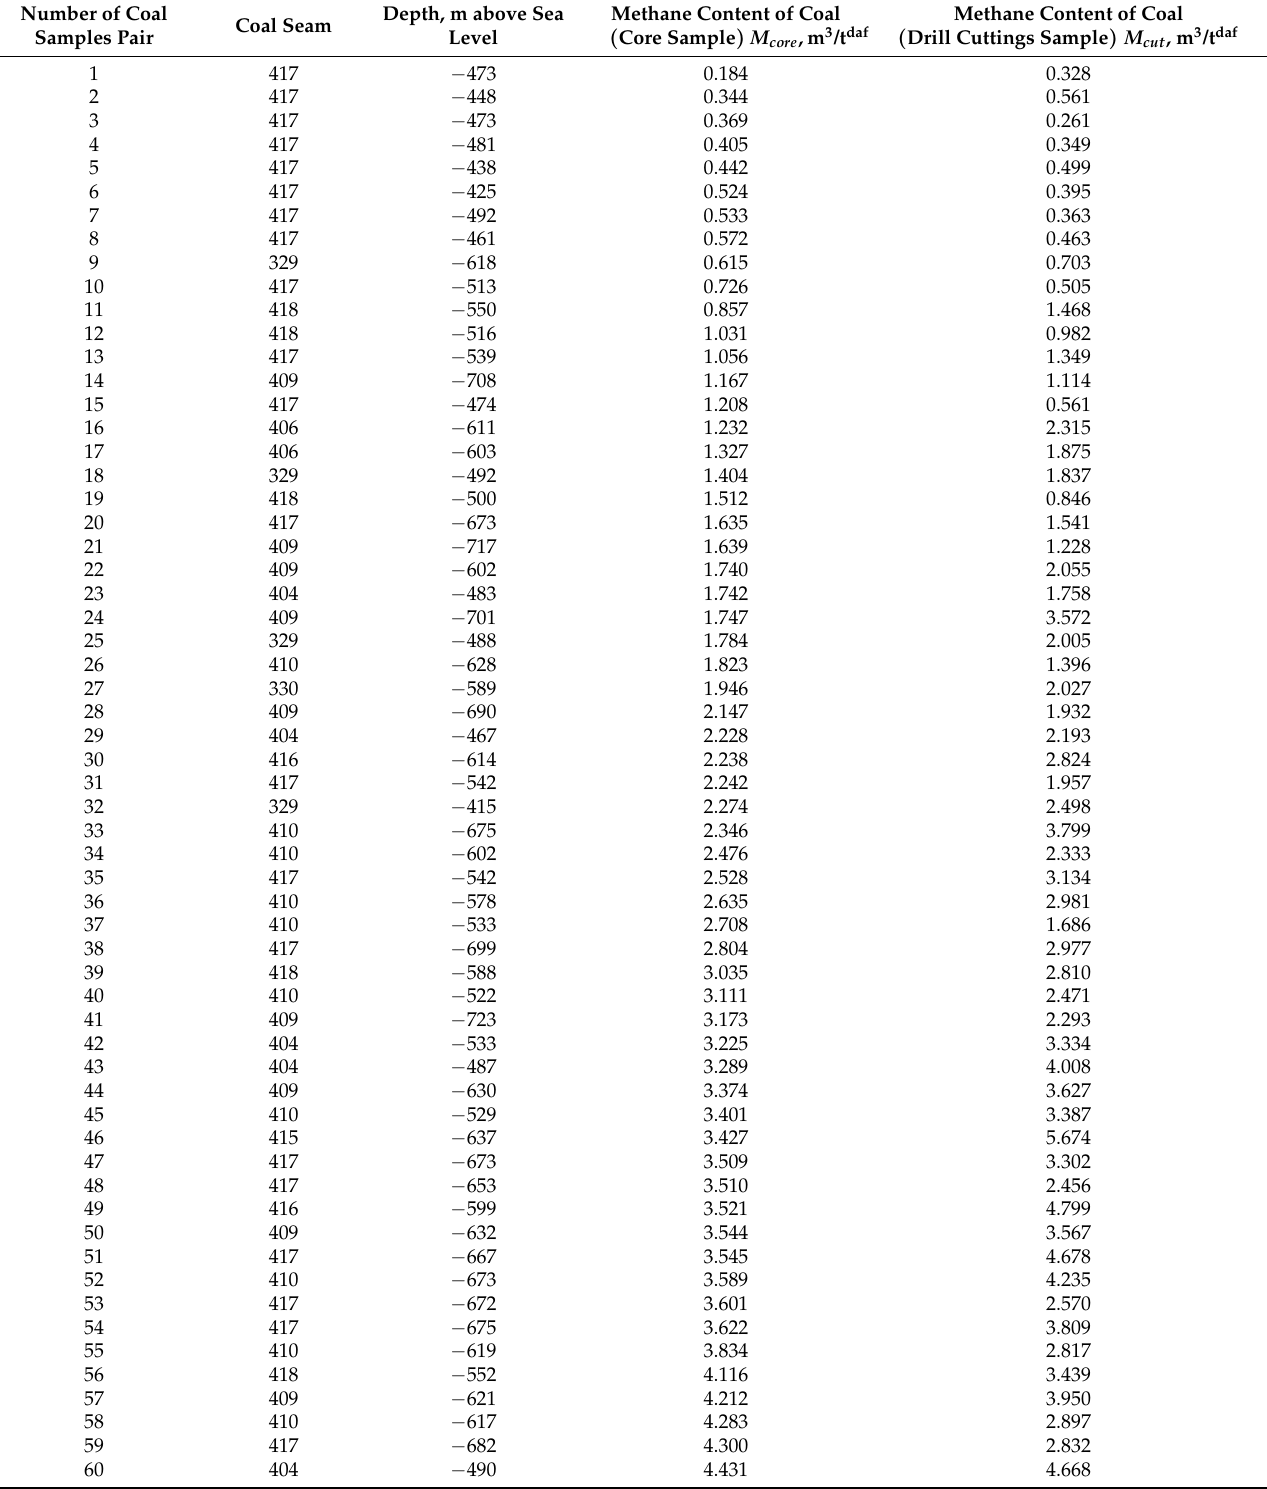
Table 1. Results of methane content of coal determinations based on drill cuttings and core